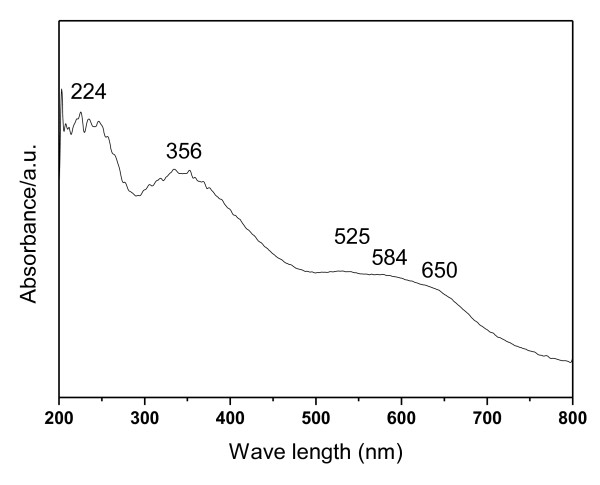
UV-Vis DRS of Co-SiO2.